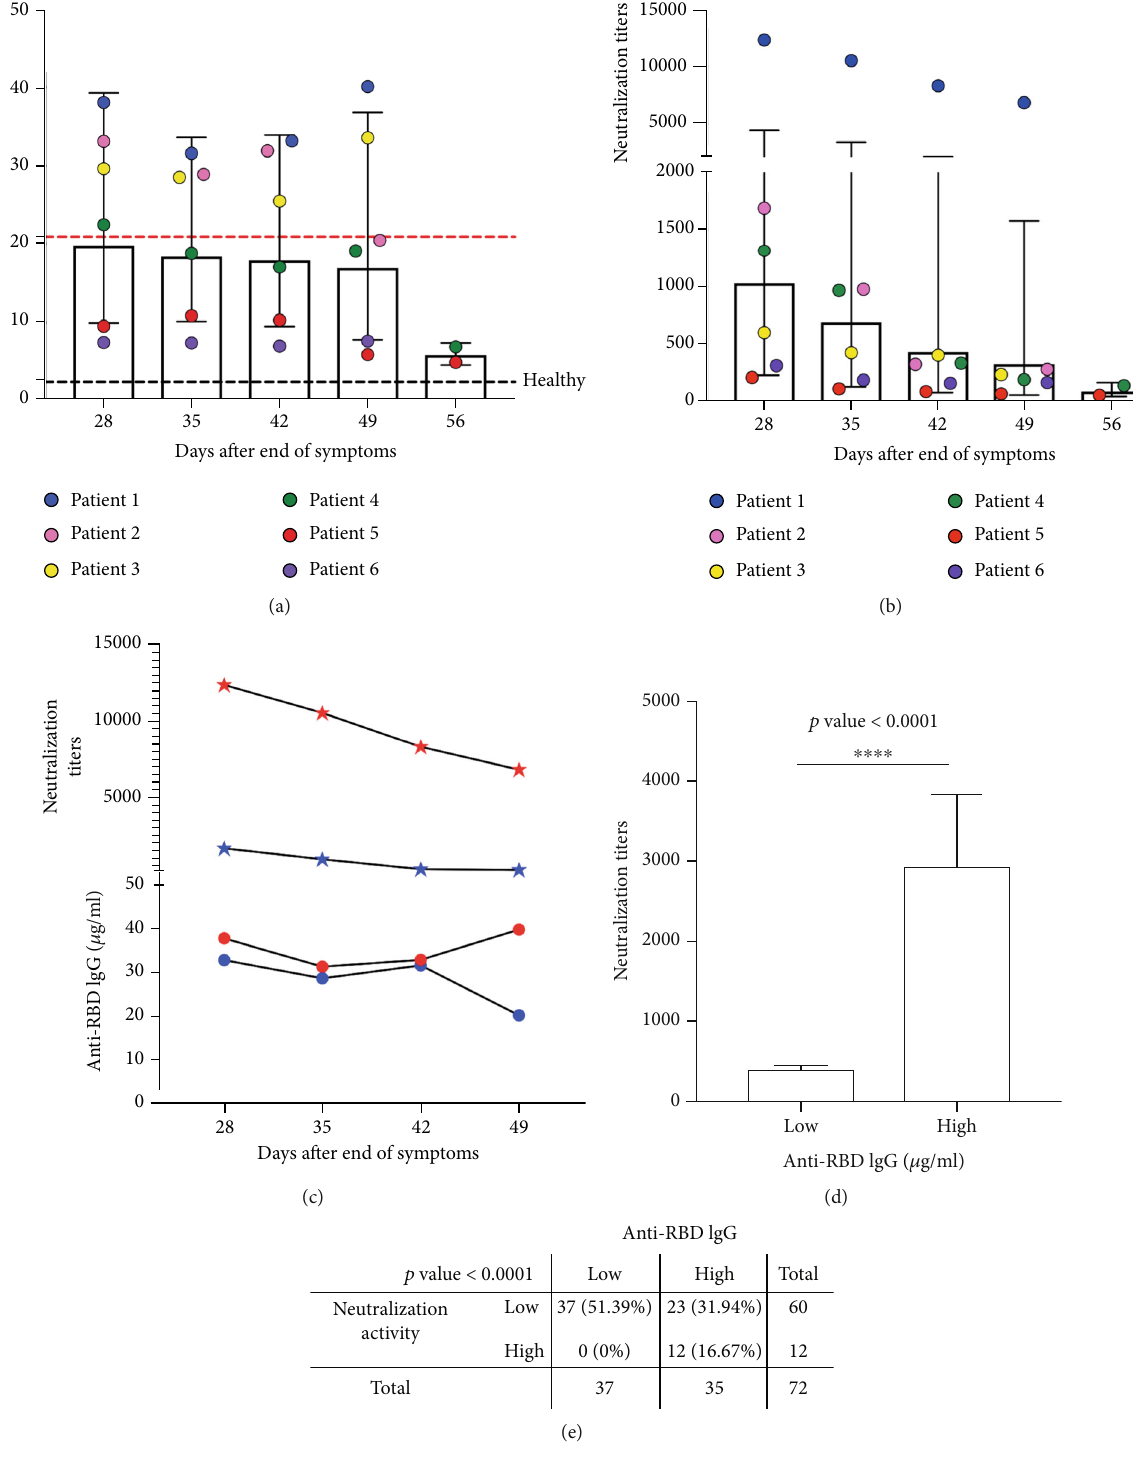
Figure 3: Convalescent plasma donors and IgG antiviral levels. Anti-RBD IgG concentration (a) and neutralizing activity (b) were determined at di ff erent days of convalescence. In (c), representative cases with a similar IgG concentration and decreasing neutralizing antibodies. (d) Neutralization activity and IgG levels; average neutralizing activity was represented for strati fi ed high ( N = 20 ) and low ( N = 52 ) IgG anti-RBD cases based on the 75th percentile. The results are presented as the mean ± SEM , and statistical di ff erences from the Mann – Whitney test are shown. (e) 2 × 2 contingence analysis for high/low antibody levels (P75) and high/low neutralizing activity (median ID80). 75th percentile (P75) and IgG cut-o ff are indicated in red and black dotted lines,